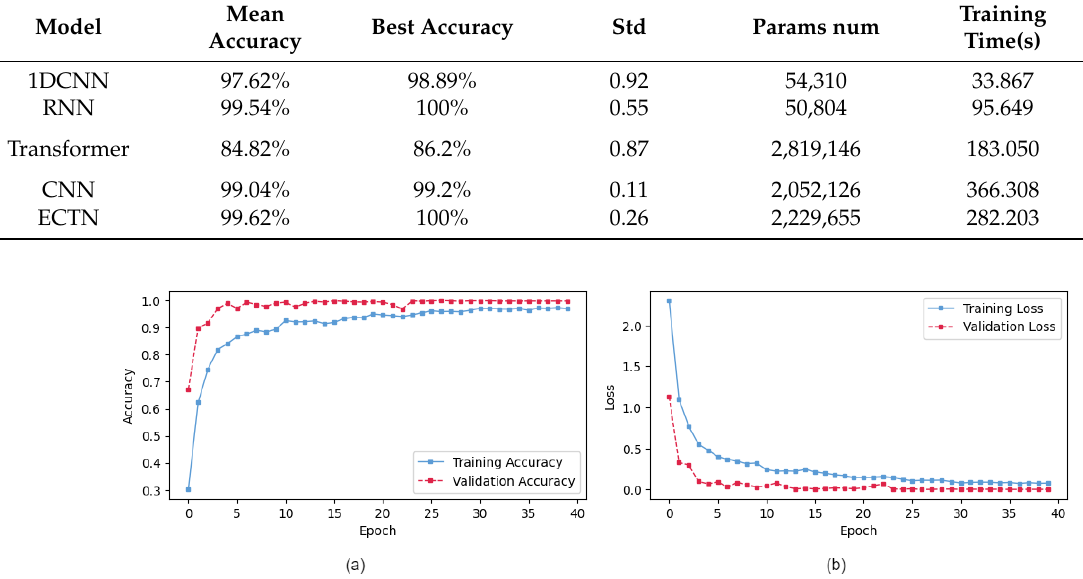
Figure 9. The ( a ) accuracy and ( b ) loss of the proposed